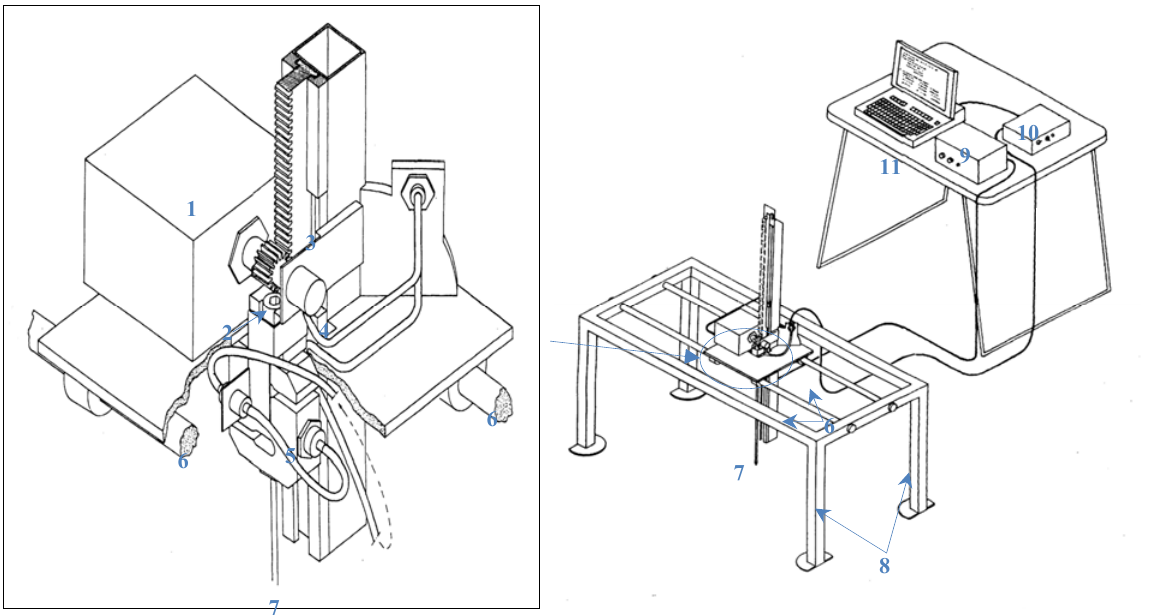
Figure 1. Electrical soil cone penetrometer. (1) Electric motor, (2) pinion, (3) zip, (4) potentiometer, (5) load cell, (6) guides, (7) driving shaft, (8) frame, (9) control unit of speed and direction of rotation, (10) signal conditioner, (11)